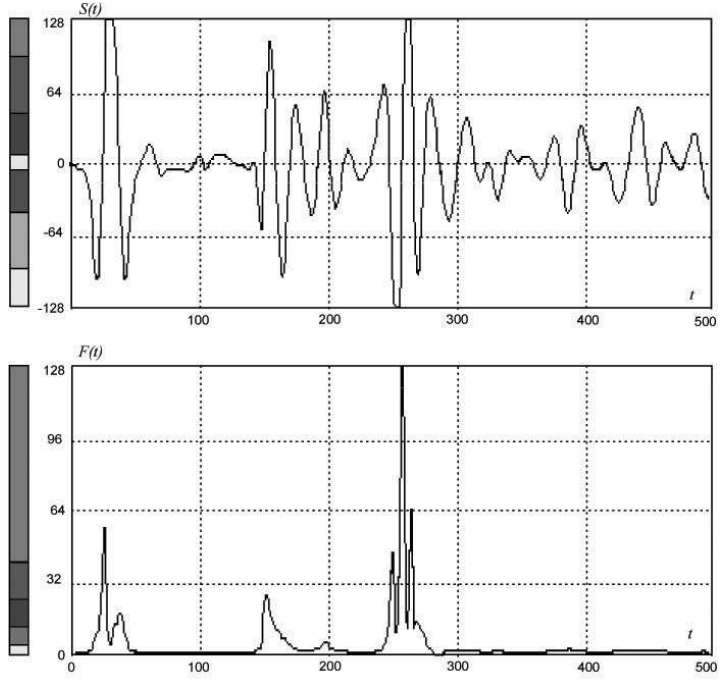
Figure 4. The example of individual signal (trace) processing by morphologic